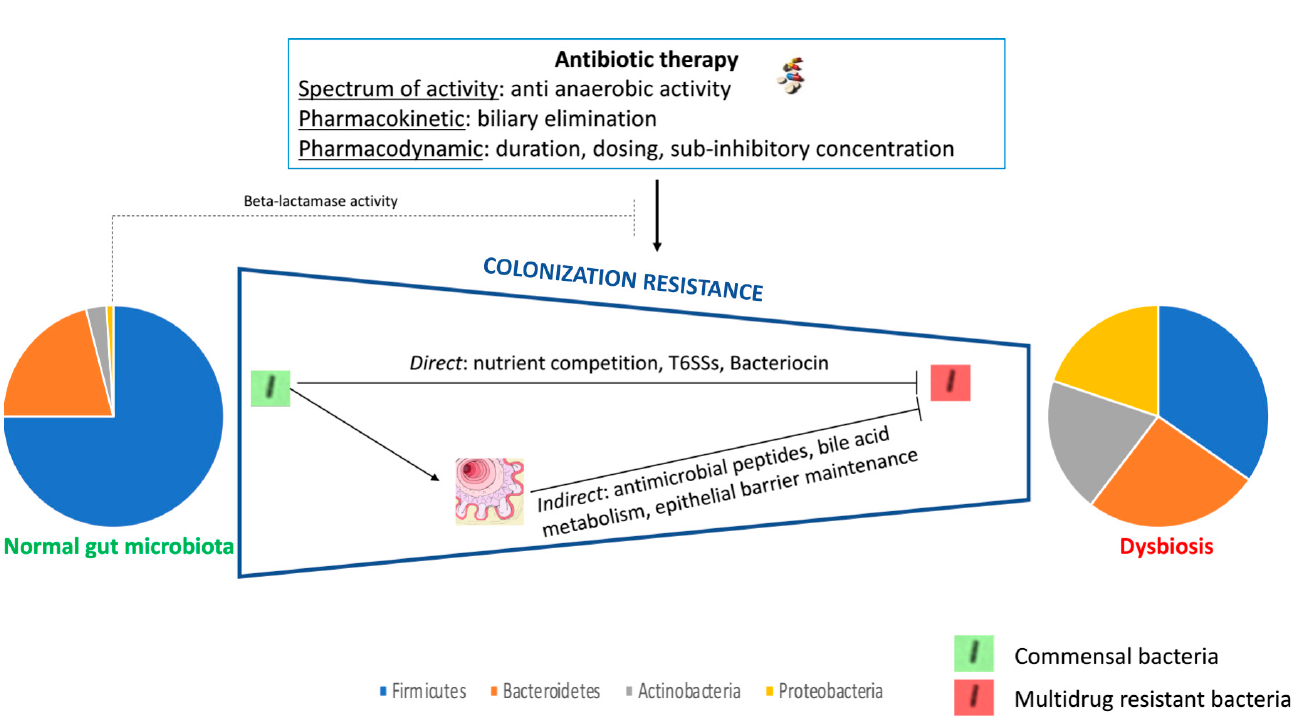
Figure 1. Impact of antibiotic therapy on gut microbiota and colonization resistance.